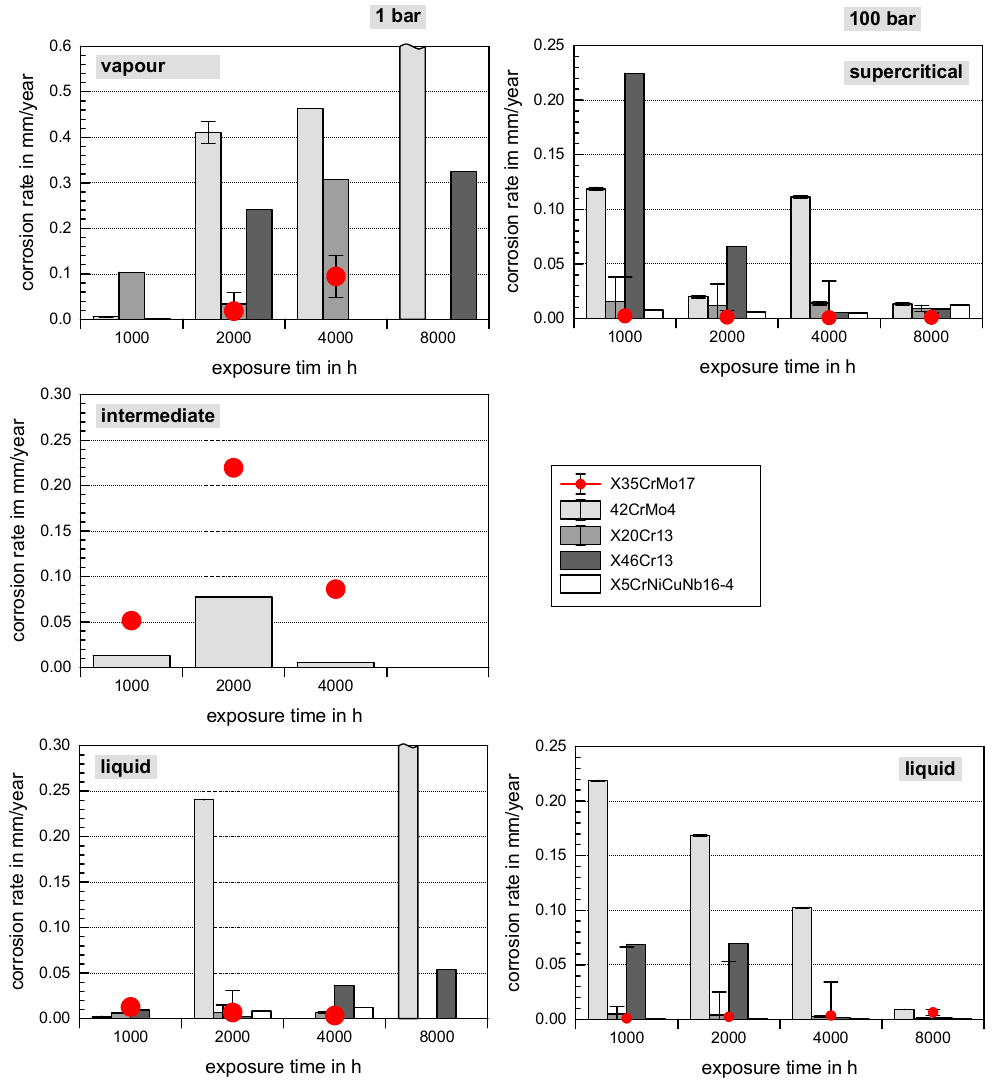
Figure 3. Arrangement of corrosion rates of X35CrMo17 to X20Cr13, X46Cr13, 42CrMo4 and X5CrNiCuNb16-4 with regard to atmosphere: the liquid, intermediate, vapor/supercritical phase at ambient pressure ( left ) and 100 bar ( right ) after 8000 h of exposure to aquifer brine water at 60 °C. Results were taken from [9,15–17,42] and combined.